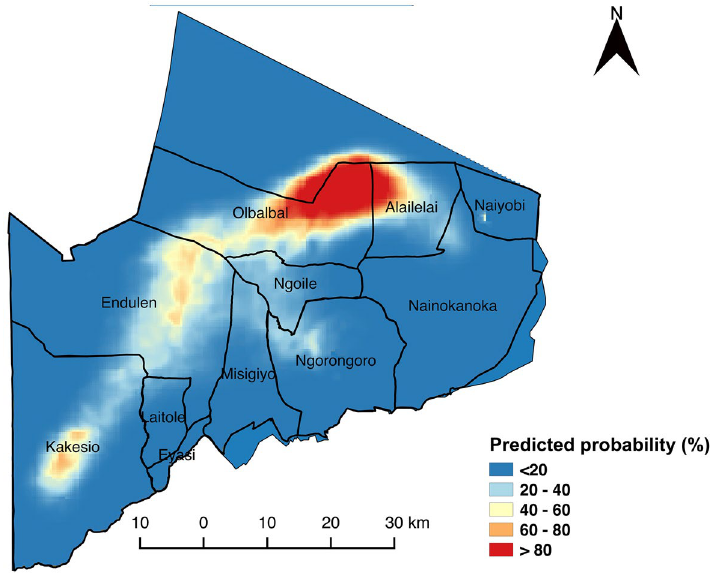
Figure 6. Predicted probability of being an anthrax-risk area in the Ngorongoro Conservation Area. The predicted probability of risk is based on data defining high-risk areas, generated through participatory mapping, and explained by environmental variables associated with the risk of anthrax. The map was created in QGIS 2.18.2; the Ngorongoro Conservation Area was sourced from the National Bureau of Statistics, Tanzania (http:// www. nbs. go.